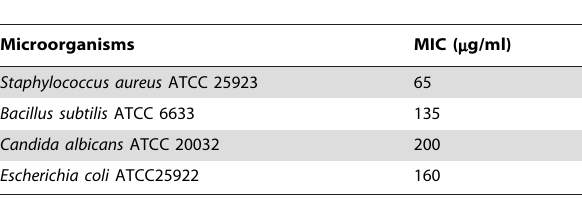
Table 1. Antimicrobial activity of b -defensin CFDB.